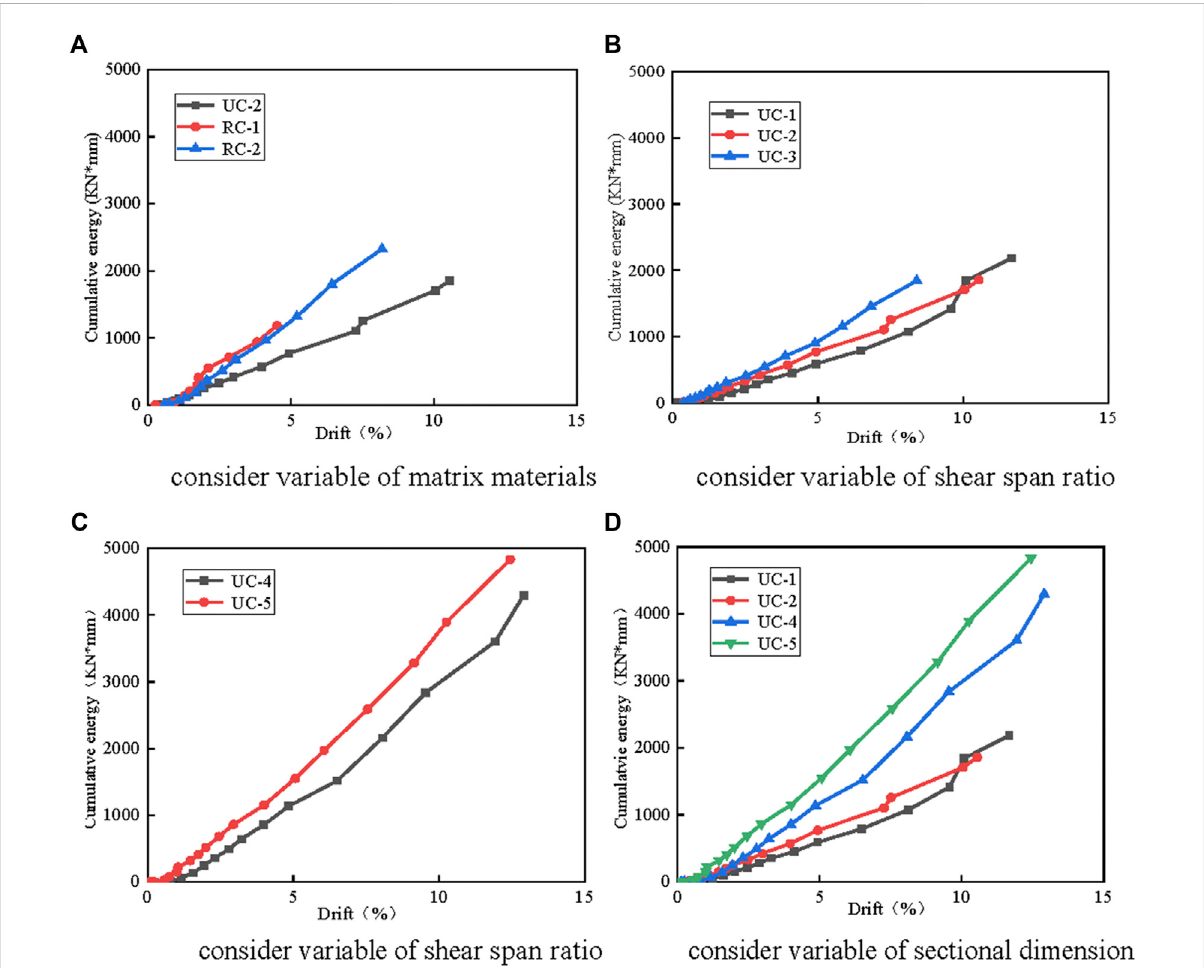
FIGURE 9 Cumulative energy dissipation curves. (A) Difference induced by introducing ECC. (B) In fl uence of shear span ratio. (C) In fl uence of shear span ratio. (D) In fl uence of sectional